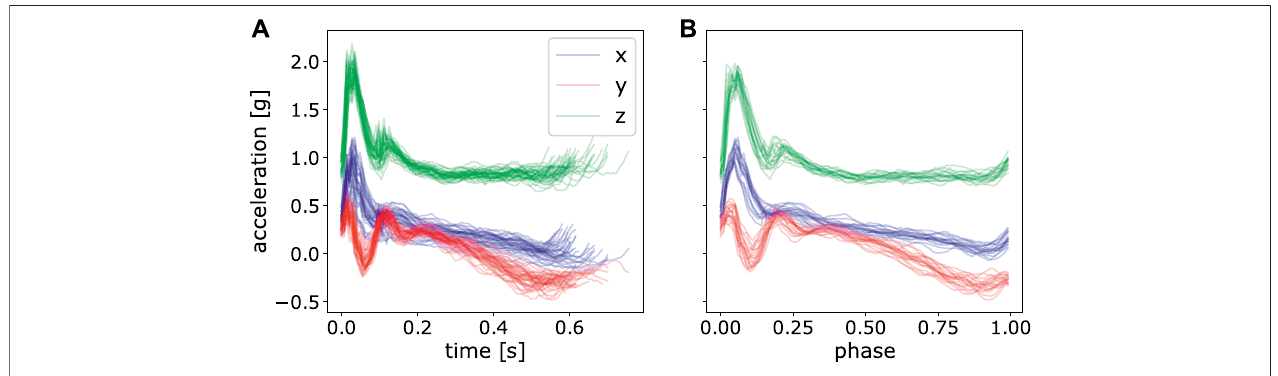
FIGURE 5 | Perform time normalization over all the segmented acceleration data with various time length. (A) only segmented data, but not normalized, (B) segmented and normalized data of the last 20 strokes.